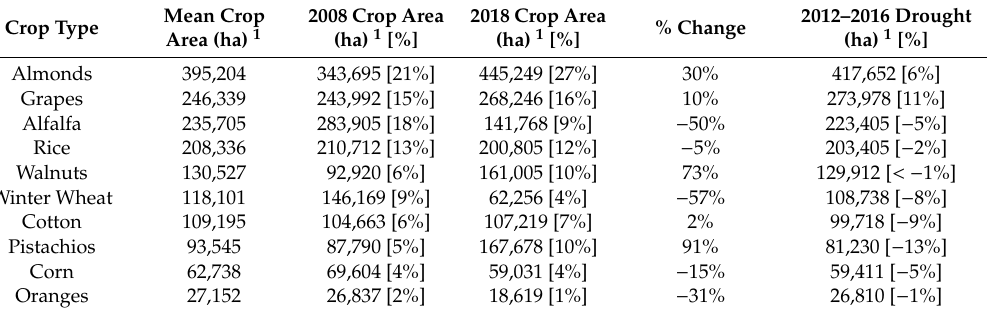
Table 2. Summary statistics of the final bias-corrected area estimates for the top 10 major crops in the Central Valley from 2008 to 2018 ordered by mean area including: (1) the 2008–2018 mean crop area in hectares, (2) the crop area in 2008 including the percentage of the total, (3) the crop area in 2018 including the percentage of the total, (4) the % change in crop area between 2008 and 2018, and (5) the mean crop area during the 2012–2016 California drought including the percent deviation from